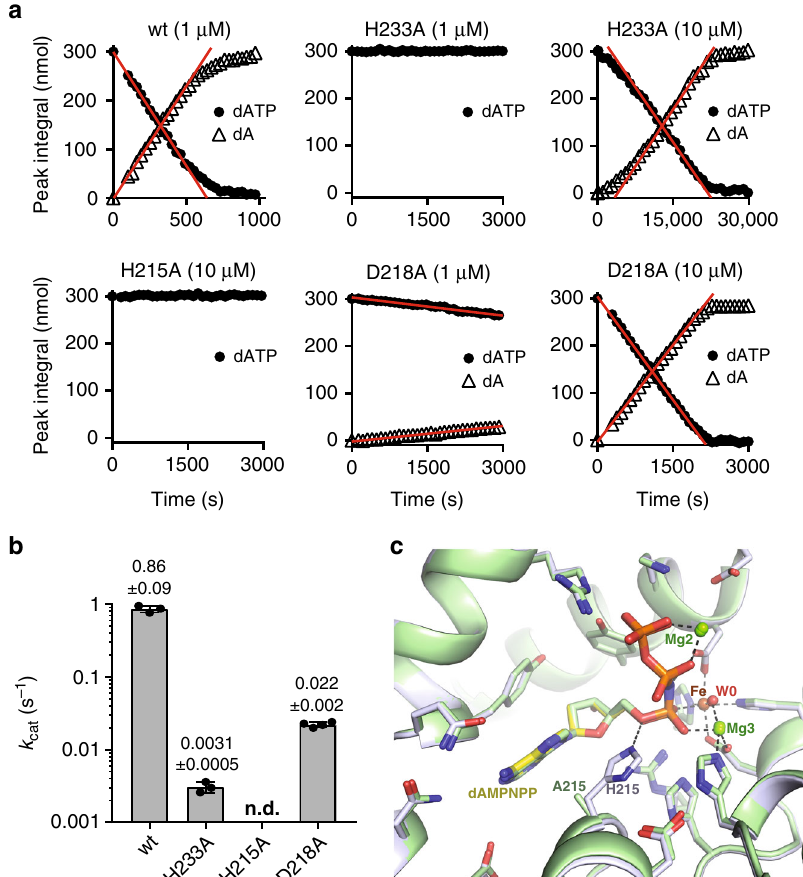
Fig. 6 Catalytic activity of SAMHD1-active site mutants. a 1 H NMR analysis of GTP-stimulated dATP hydrolysis by wt-SAMHD1 and active site mutants H233A, H215A and D218A. 1 H NMR data were recorded for SAMHD1 hydrolysis reactions containing wt-SAMHD1 (1 µ M) or active site mutants H233A (1 and 10 µ M), H215A (10 µ M) and D218A (1 and 10 µ M) with 0.2 mM GTP AL1-activator and 0.5 mM dATP. In each panel, the integral of resolved substrate and product peak resonances is plotted against time. Initial rates of hydrolysis were determined from slopes (red lines) derived from the data measured in the linear part of the reaction. b Bar chart of the apparent k cat values derived from the data shown in a . Points overlaid in each bar are the individual data measurements, the error bars represent the s.d. of at least three independent measurements, n.d. (not detectable). The source data are provided in the Source Data fi le. c Overlay of the active site in the crystal structures of D137N-SAMHD1(109-626)-XTP-dApNHpp and H215A – SAMHD1(109-626)-GTP- dAMPNPP inhibitor complexes. The protein backbone is shown in cartoon representation, wt (grey) and H215A (green), bound nucleotides and active site residues are shown in stick representation, metal ions and ordered water molecules as spheres, coloured by atom type. The bound inhibitor adopts the same con fi guration in both the wt and H215A